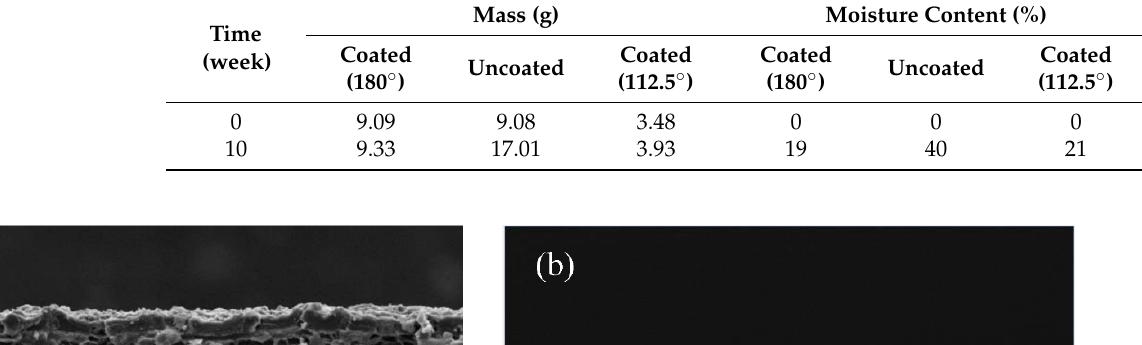
Table 7. Durability test result on bamboo samples with silica–HMDS coating.